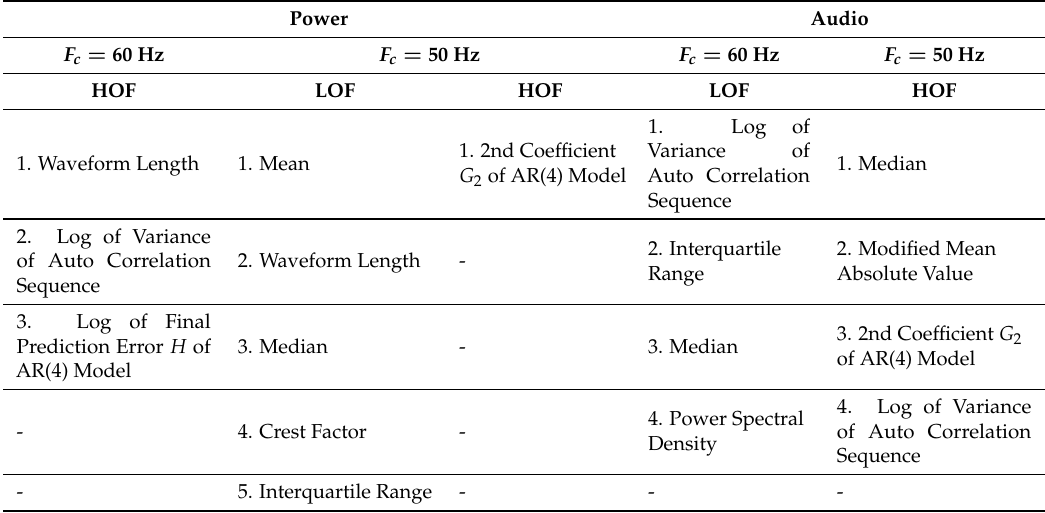
Table 2. Extracted Feature Vectors from the high outliers frequency (HOF) and low outliers frequency (LOF) Segments of the Original 60 Hz and 50 Hz ENF